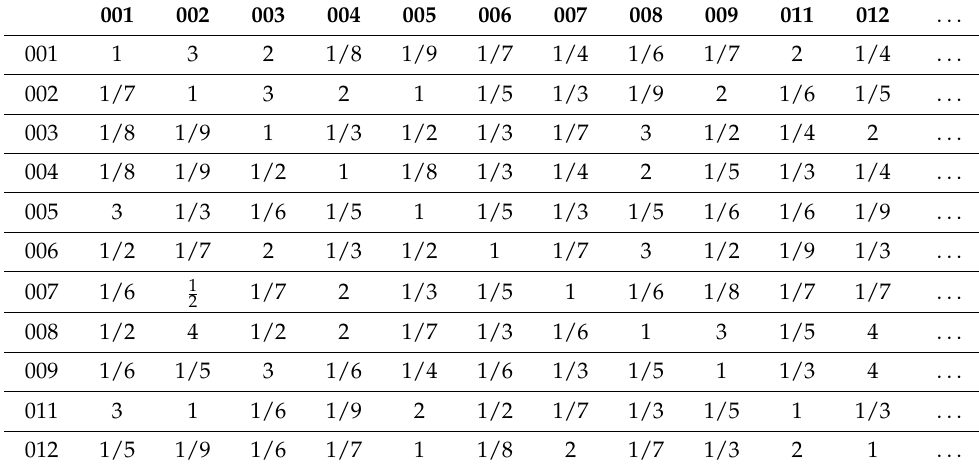
Table 3. Pair-wise evaluation matrix of the criteria layer.